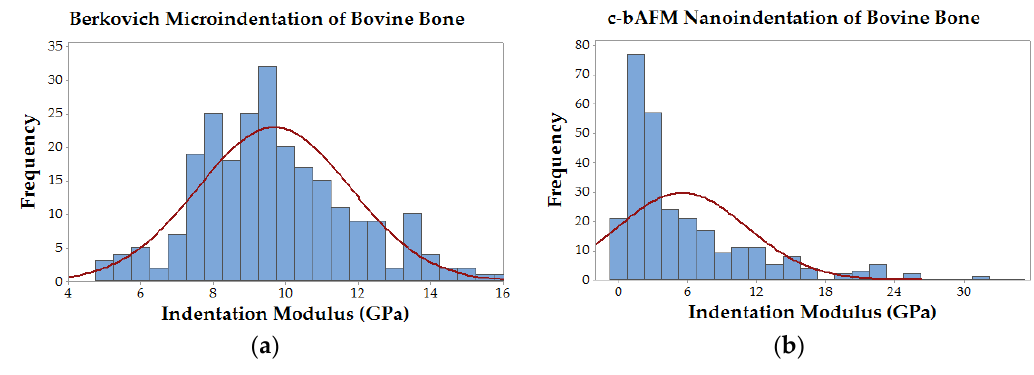
Figure 7. Histograms of modulus data from native bovine bone comparing